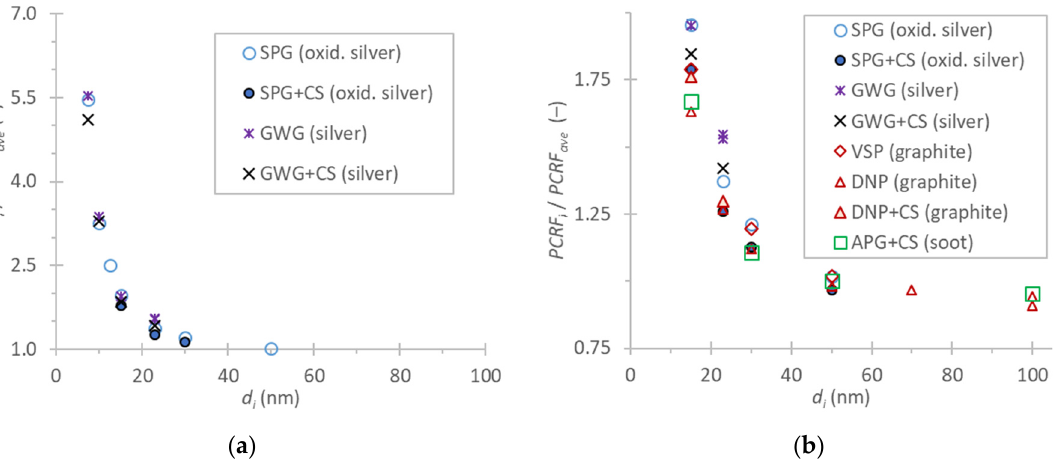
Figure 6. PCRF ratio to PCRF ave at different sizes (inverse of Equation (6)). The VPR was used with PCRF 100: ( a ) silver particles; ( b ) all materials. Lines give fittings to the experimental data of “high” and “low” efficiencies (inverse of PCRF s).